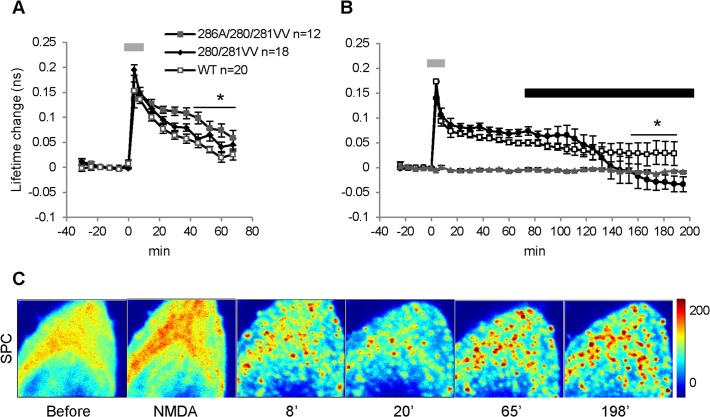
Persistent Camui activity is Ca2+-dependent.(A) Summary plots of Camui activation in control experiments (open squares, WT Camui, n = 16) and experiments with Camui mutants (286A/280V/281V, filled squares, n = 18) (280V/281V, n = 12 filled diamond) in response to 7.5 min of the NMDA treatment (grey bar). The magnitude of the activation of Camui mutants was significantly larger than that of WT Camui (thin horizontal line, p < 0.05 for both mutants). (B) Application of ACSF containing 0 mM Ca2+ and 5 mM EGTA (black horizontal bar) at 60 min after the 7.5 min of NMDA treatment (grey bar) effectively reversed persistent Camui activation (EGTA, n = 6, circles, p < 0.05), while Camui activity remained persistent in control experiments without lowering Ca2+ (Control, n = 6, squares). Baseline control (n = 3, triangles) was stable for the duration of the experiments (> 3.5 hours). (C) SPC images before, during, and at different times after the NMDA treatment show that Camui clusters persisted during the whole experiment and were not dissolved at the end of the experiment after the prolonged exposure to 0 mM Ca2+/5 mM EGTA ACSF (198’).